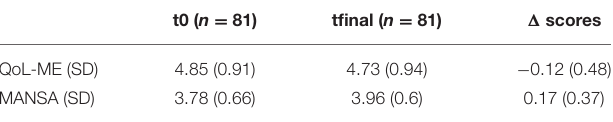
TABLE 3 | Overview of the number of selections, mean scores at t0 and internal consistency of the eight additional modules ( N = 121). Additional module